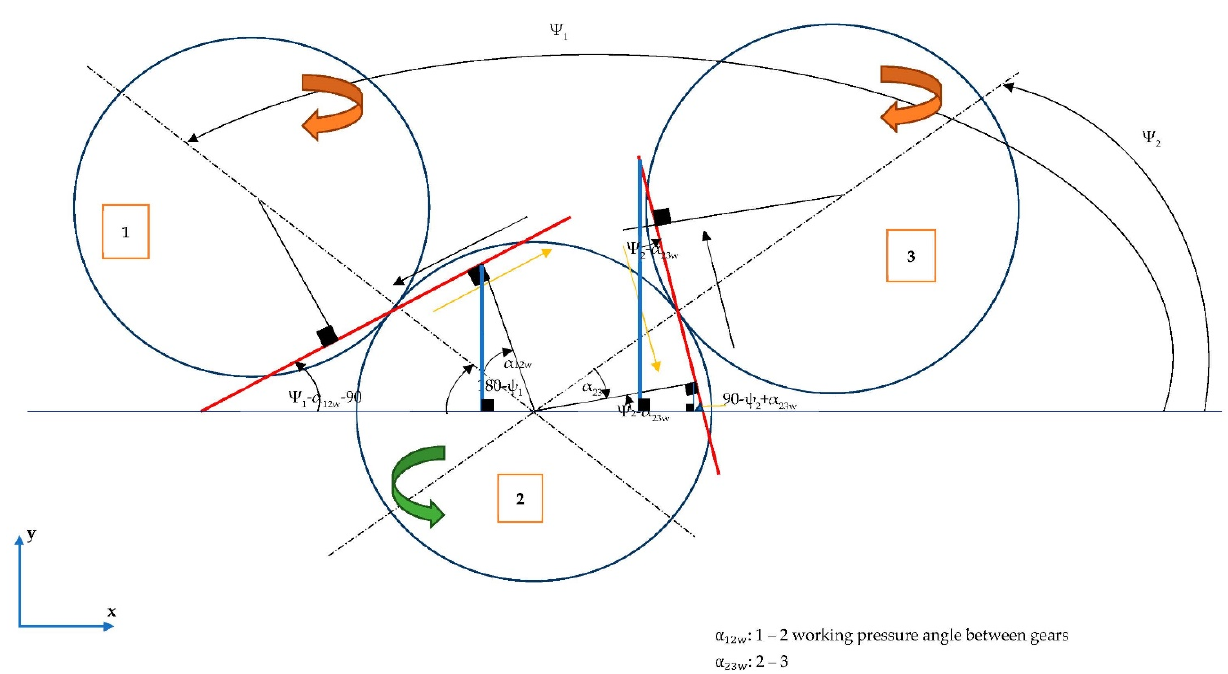
Figure A1. The friction force direction determination.